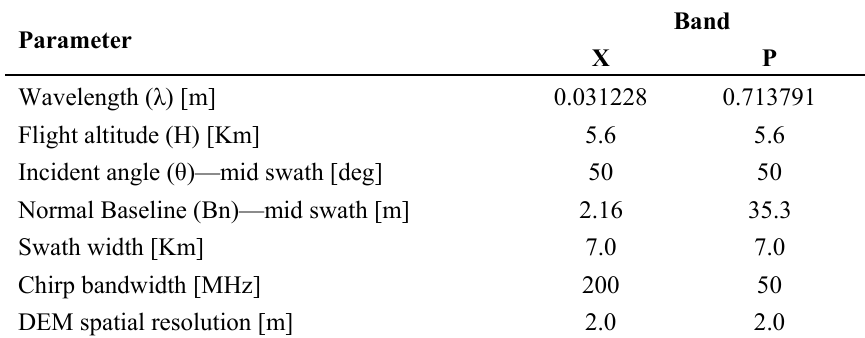
Table 2. OrbiSAR-1 System-flight parameters.